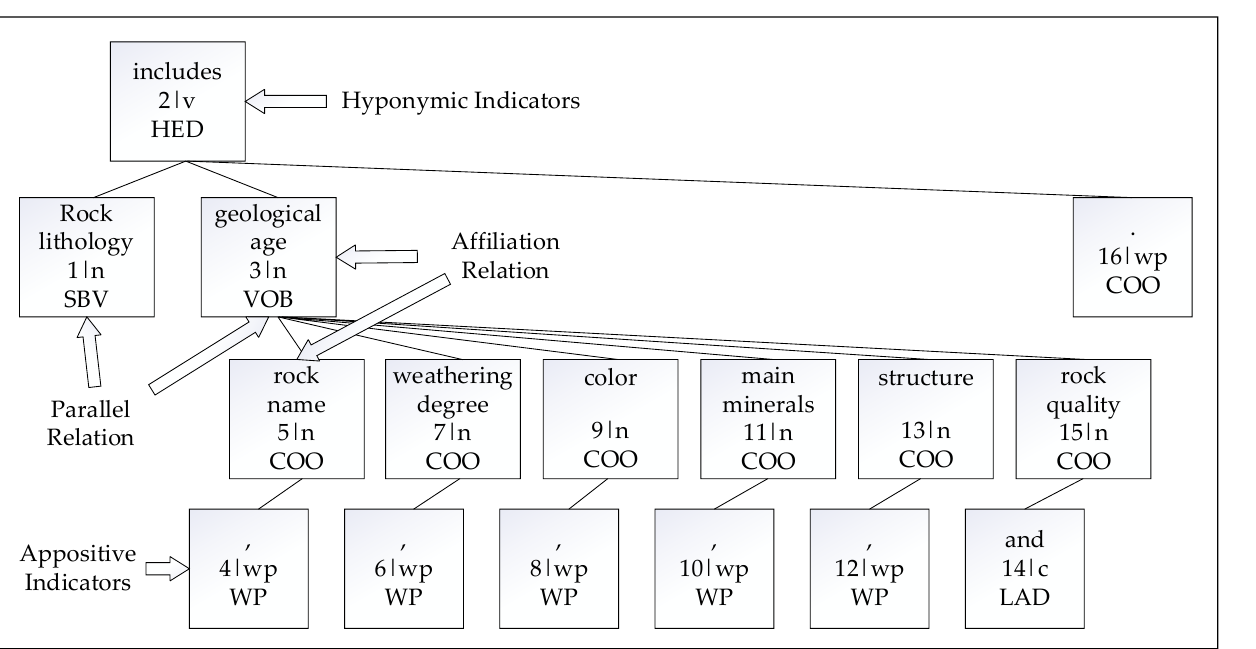
Figure 3. Example of Chinese-language text pattern analysis.